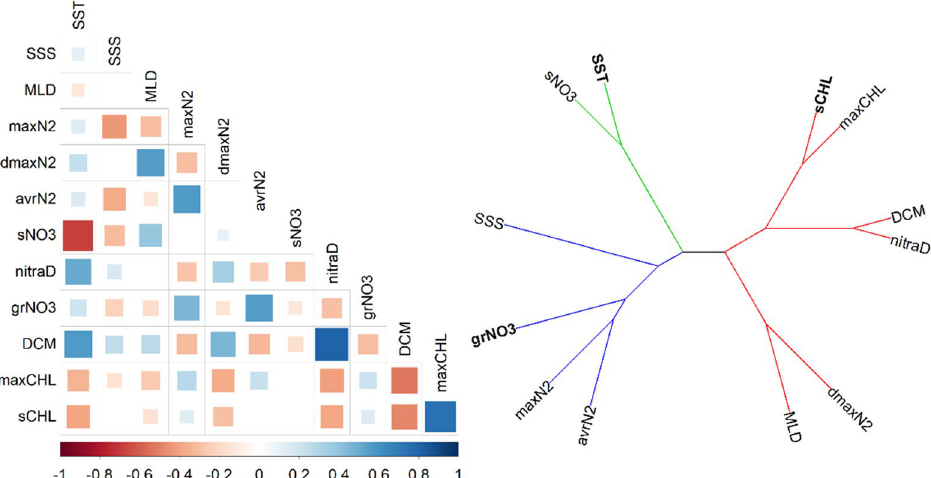
Figure 4. Correlogram and dendrogram. Left: Correlogram of predictive variables where statistically significant correlations (statistical confidence level of 95%) are shown. The test was based on Pearson’s product moment correlation, and alternative hypothesis include both sides. A Bonferroni correction was applied to p-values to control Type-I error. The color indicates the sign and the size indicate the magnitude of the correlation. Right: Dendrogram created using the correlations between predictive variables. Dissimilarity was established as 1- |correlation|. Bold letters indicate the predictors selected to be used in the simplified 3-variable models.